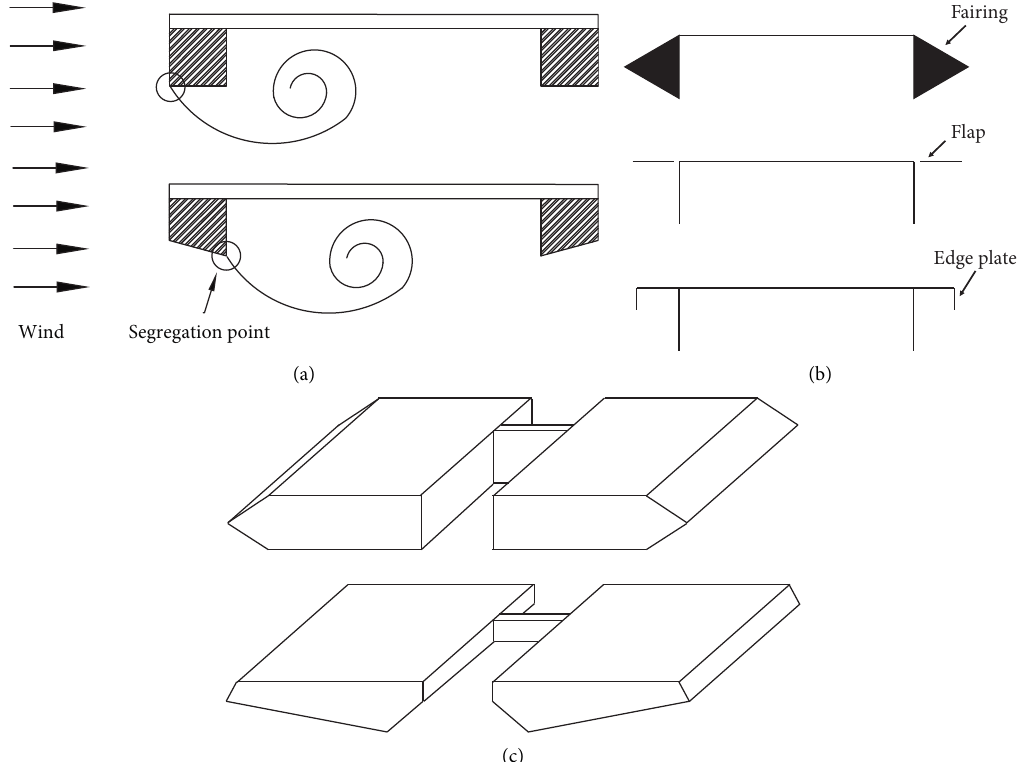
Figure 2: Methods to improve the aerodynamic performance: (a) shape change, (b) additional attachment, and (c)